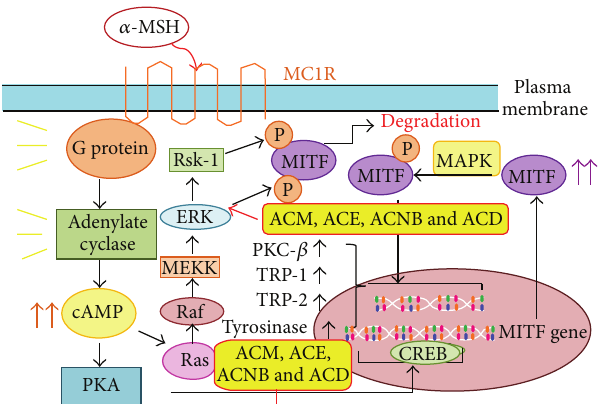
Figure 5: Antimelanogenesis biological mechanism of A. communis